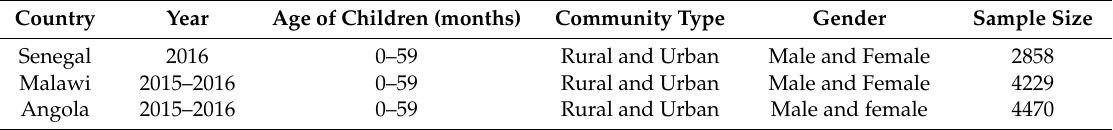
Table 2. Summary statistics of pooled